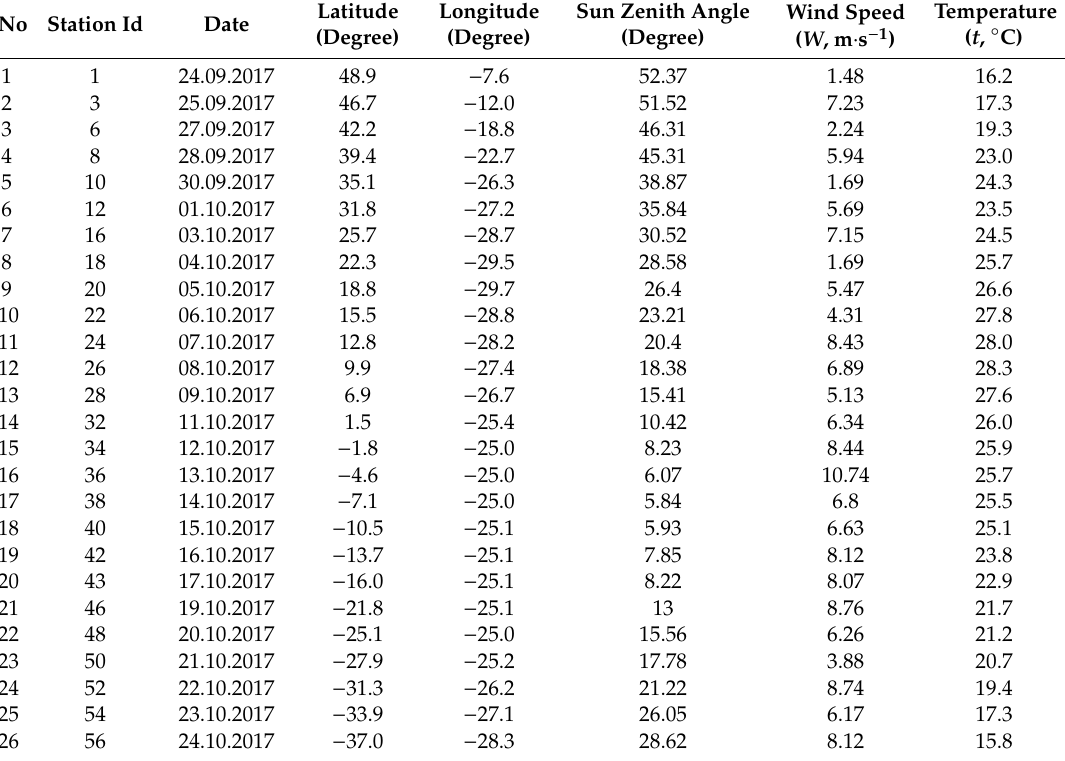
Table 1. Overview of measurement conditions during the midday station during